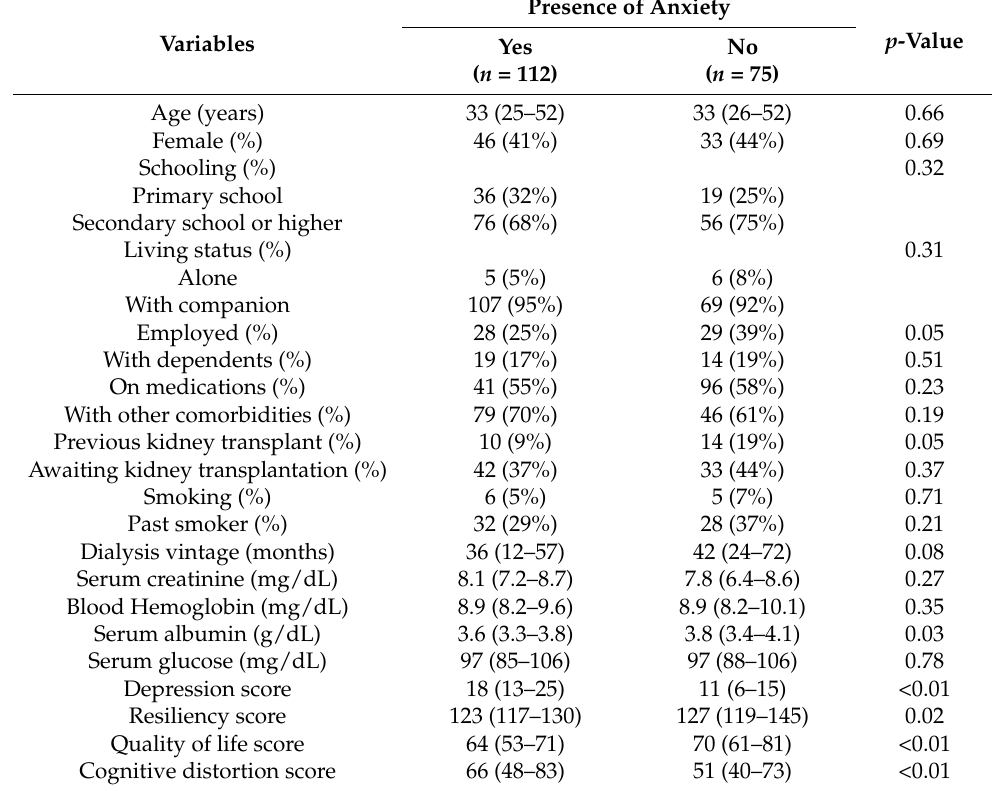
Table 2. Socio-demographic, clinical characteristics, and psychological variables of patients with and without anxiety (total BAI score ≥ 10 points). Data is shown as median (percentile 25–percentile 75) or absolute value